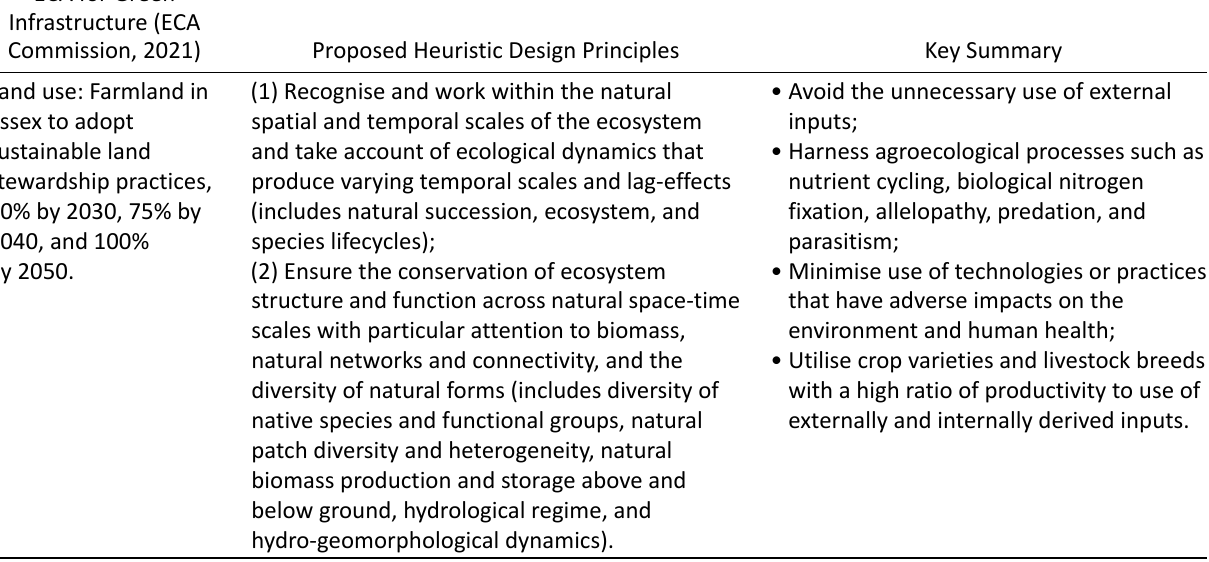
Table 1. ECA and heuristic design principle evaluation chart. This table shows the evaluation of ECA recommendations through theoretical application of proposed heuristic design principles to the ECA recommendations. The key summary demonstrates proposed action points for the ECA recommendations with an enhanced approach to ecosystem‐led plan‐ ning and